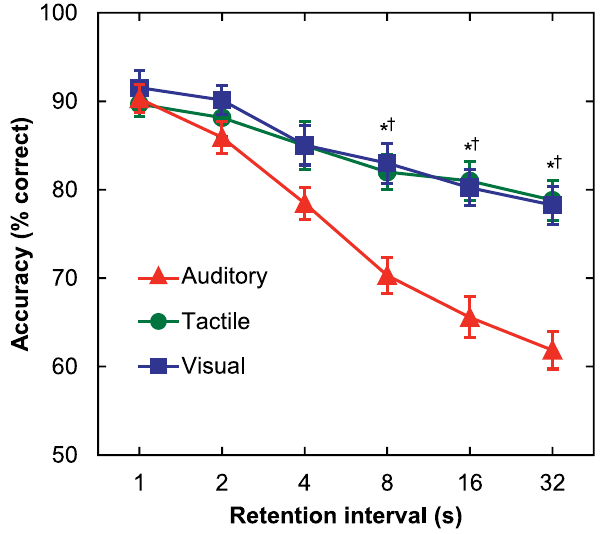
Figure 1. Experiment 1: Mean ( 6 SEM) short-term memory accuracy among sensory modalities for simple, artificial stimuli. Short-term retention of auditory stimuli declines at a greater rate than retention of visual or tactile stimuli. There were no differences in accuracy among the sensory modalities for trials with brief retention intervals (1–4 s), indicating that the initial discriminability of the stimuli was approximately equal. However, at longer retention intervals (8– 32 s), accuracy for auditory trials was significantly lower than visual and tactile trials. Post-hoc tests ( p , .05, Bonferroni correction for multiple comparisons): *Accuracy in the auditory block significantly lower than the tactile block. { Accuracy in the auditory block significantly lower than the visual